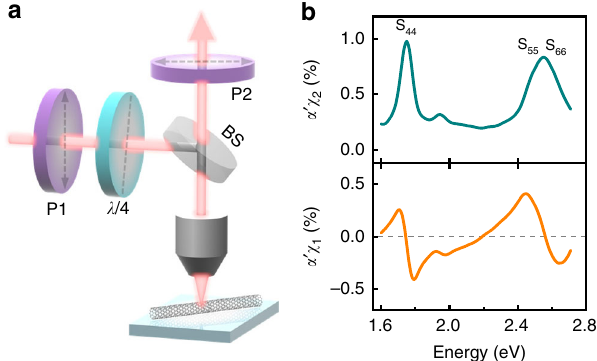
Fig. 4 On-chip complex optical susceptibility detection of individual nanotubes. a Scheme of the experiment setup in the re fl ection con fi guration. Beam splitter was abbreviated to BS. b Imaginary ( χ 2 , green) and real ( χ 1 , orange) susceptibilities of nanotube (25,11) on fused quartz substrate. α ' is a detection coef fi cient. Optical transitions are marked above each peak. S 55 and S 66 transitions are very close with